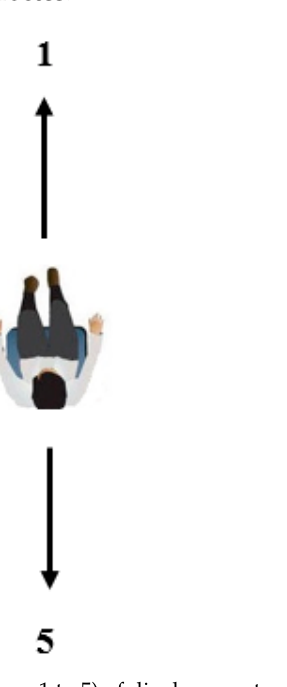
Table 1. Average experimental trunk stiffness [18] reduced to five directions.